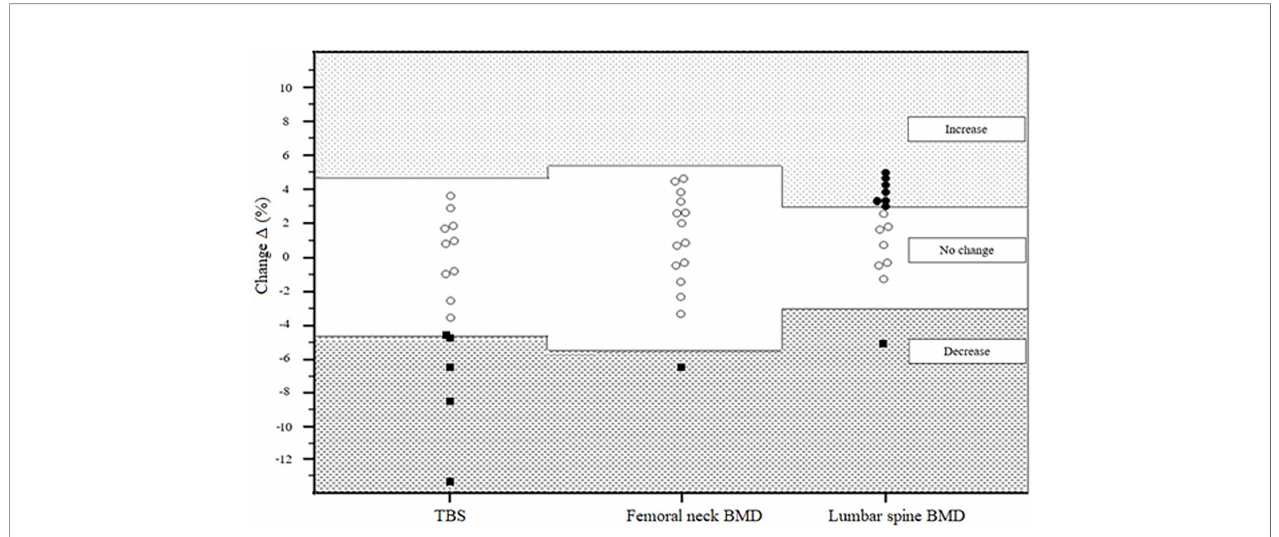
FIGURE 1 | Percentage of TBS and BMD changes according to the LSC criteria in 15 patients after IVMP therapy. TBS trabecular bone score BMD bone mineral density LSC least signi fi cant change IVMP intravenous methylprednisolone. Bullets and squares represent individual percentage of BMD and TBS changes (black squares represent a decrease in TBS or BMD – equal to or exceeding LSC calculated to be 4.6% change for TBS, 5.4% change for femoral neck and 3% change for lumbar spine; black bullets represent an increase in BMD equal to or exceeding LSC; white bullets represent no change in TBS or BMD). BMD, bone mineral density; IVMP, intravenous methylprednisolone therapy; LSC, least signi fi cant change; TBS, trabecular bone